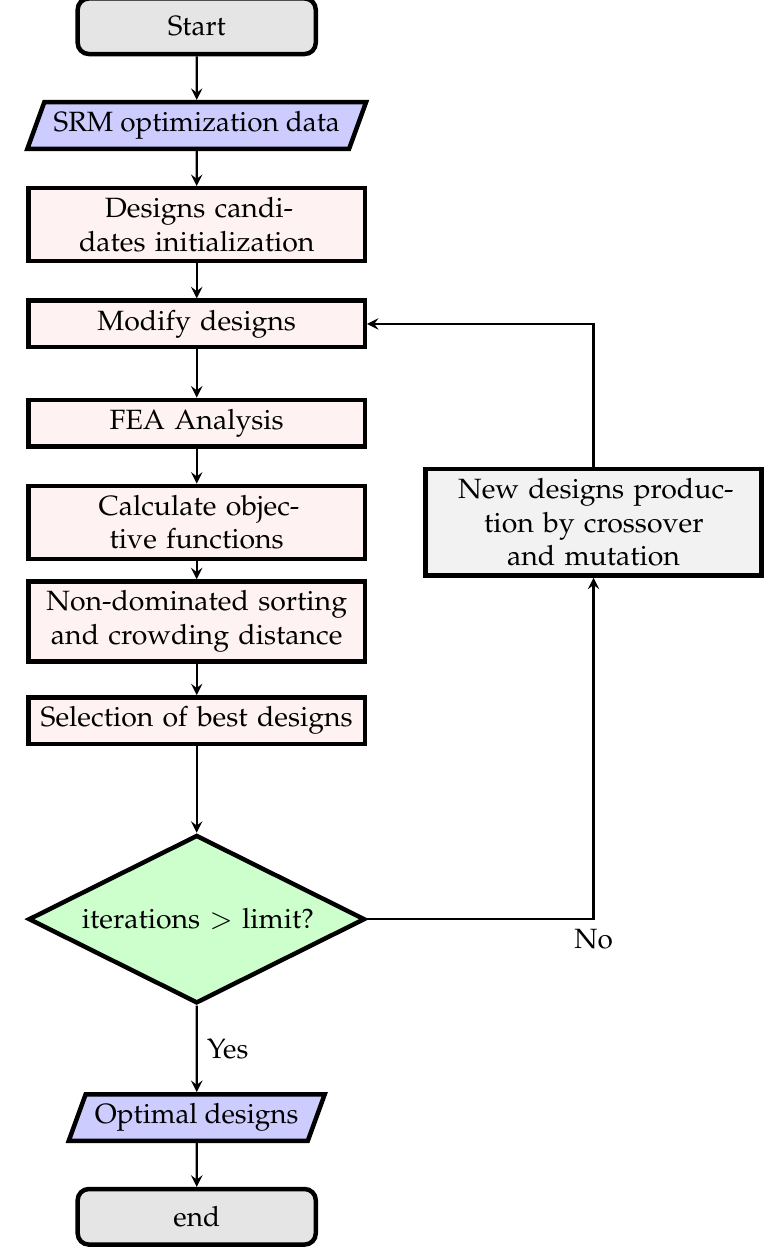
Figure 3. NSGA-II optimization program